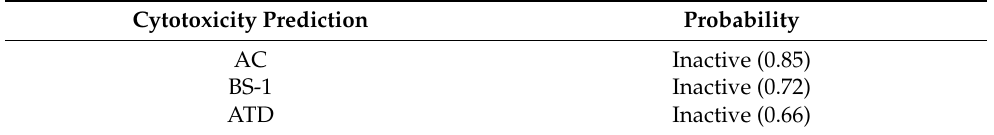
Table 3. Cytotoxicity predictions for AC, BS-1 and ATD. Probability values range from 0 to 1. Cytotoxicity analyses were performed with the ProTox-II server.